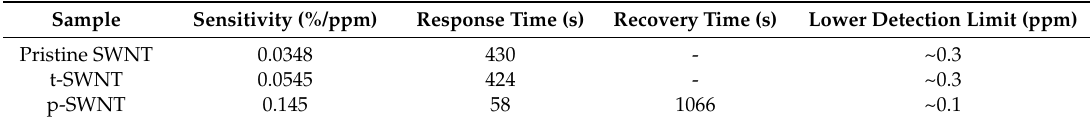
Figure 8. ( a ) Dynamic response of the modified SWNT sensors to different concentrations of NH 3 at 250 °C and ( b ) their calibration curves. Note that the p-SWNT-based sensor reaches a steady state with a slight overshoot shortly after exposure to NH 3 gas, while the t-SWNT-based and pristine SWNT-based sensors are not yet fully saturated. Table 3. Sensing performances of the modified